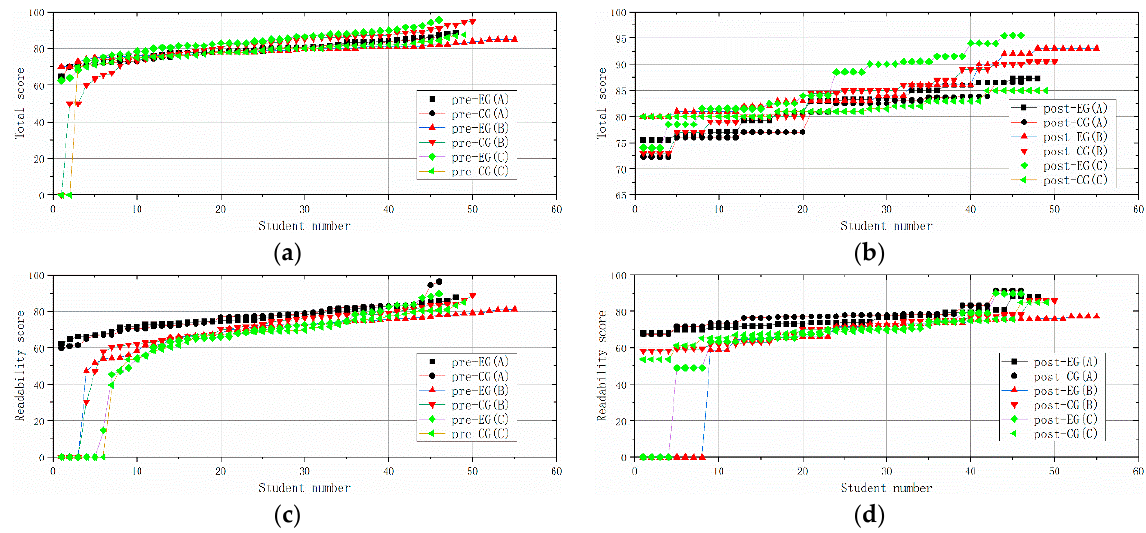
Figure 6. Comparison of pre-and posttests scores. ( a ) Comparison of pretest total scores. ( b ) Comparison of posttest total scores. ( c ) Comparison of pretest readability scores. ( d ) Comparison of posttest readability scores.